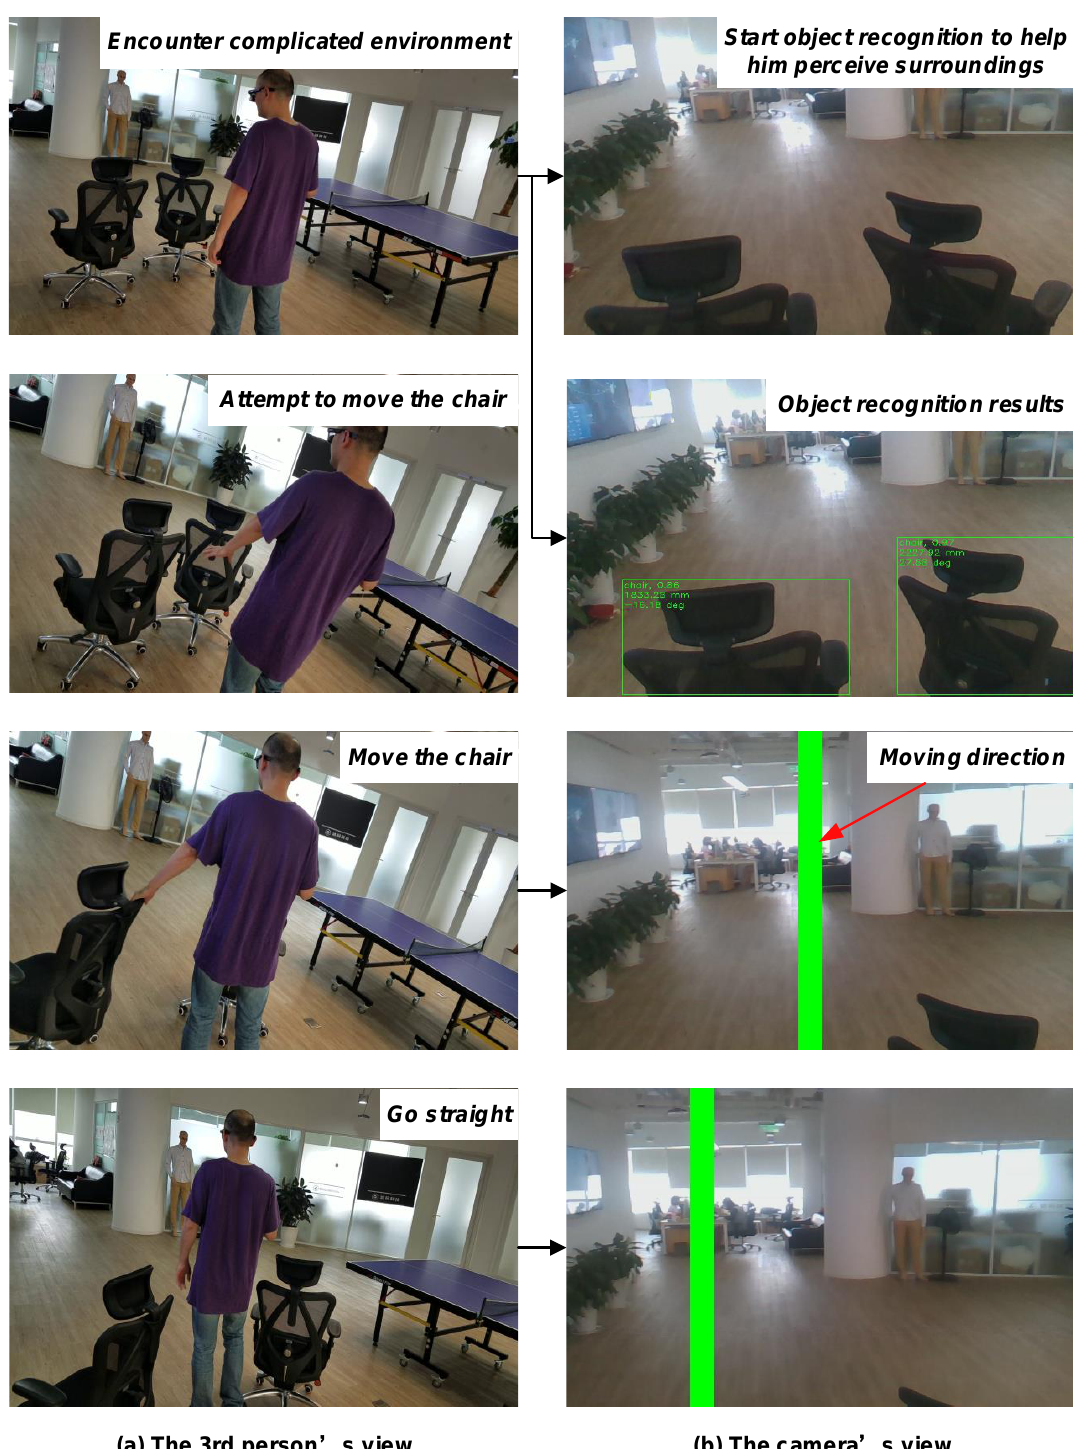
Figure 17. Example of object recognition to promote the